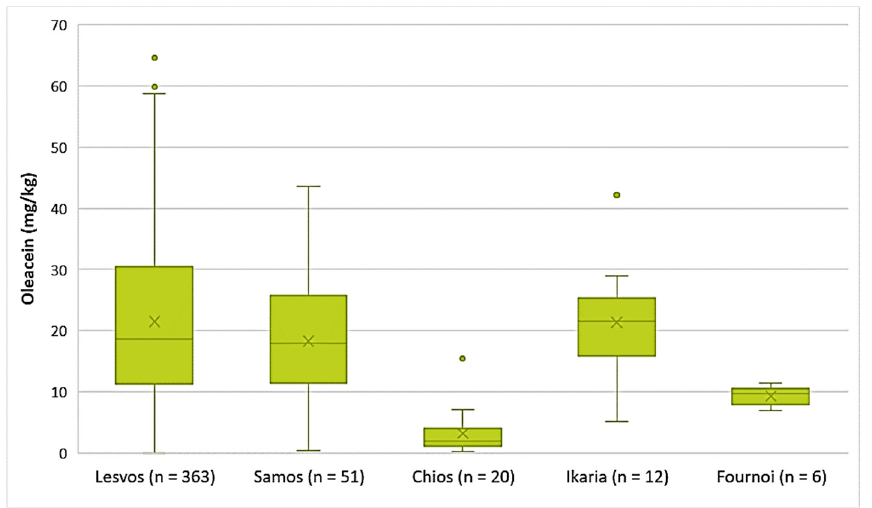
Figure 6. Concentration of oleacein (mg/kg) in EVOOs from the islands of Lesvos, Samos, Chios, Ikaria, and